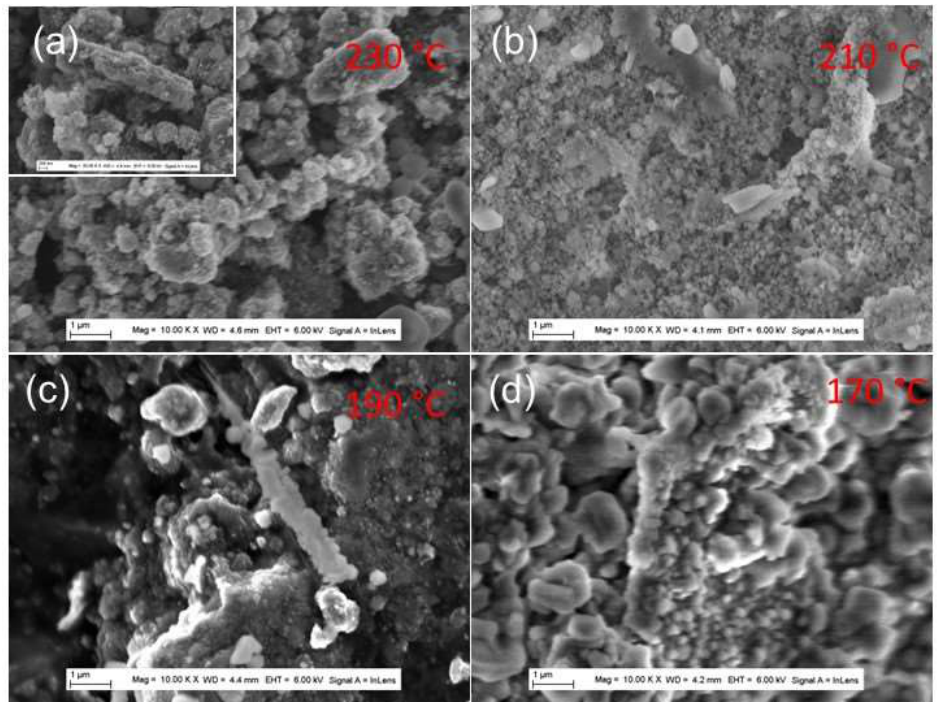
Figure 6. FEG-SEM pictures after the 10th cycle at constant current rate (0.12 C) of the TiO 2 powders prepared at the indicated temperatures and used as anode materials for LIBs, the (a) insert is the corresponding high magnification. Table 3. Crystallite size of TiO 2 powders prepared at the different synthesis temperatures.